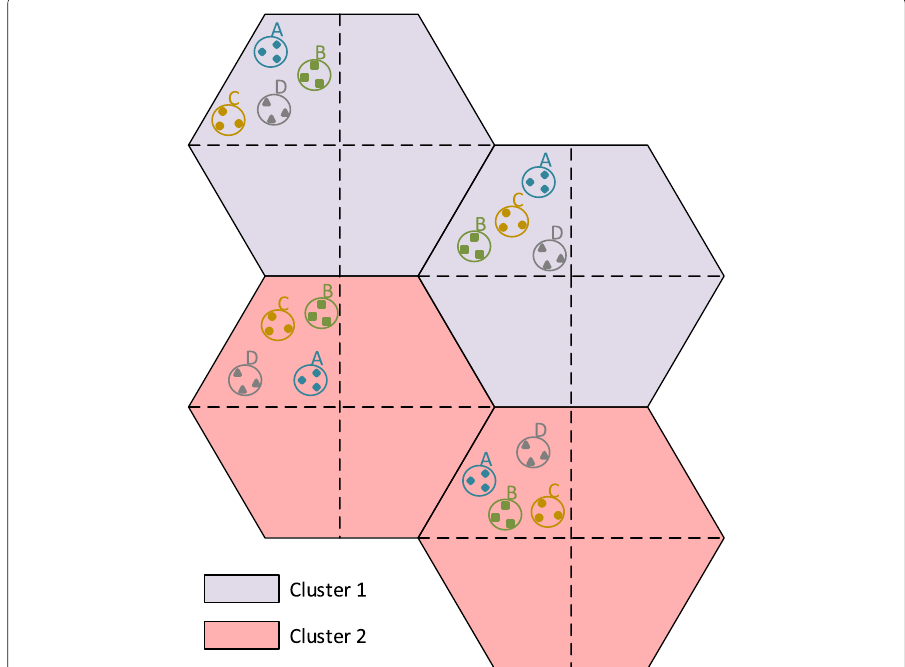
Fig. 5 Multicast scenario with groups formed with the Geographical Scheduling Algorithm